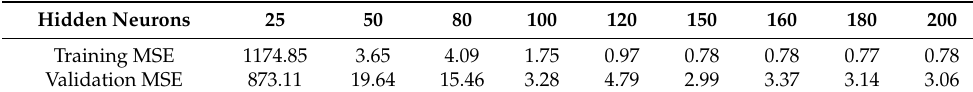
Table 6. Loss of SOC estimation in different hidden sizes.